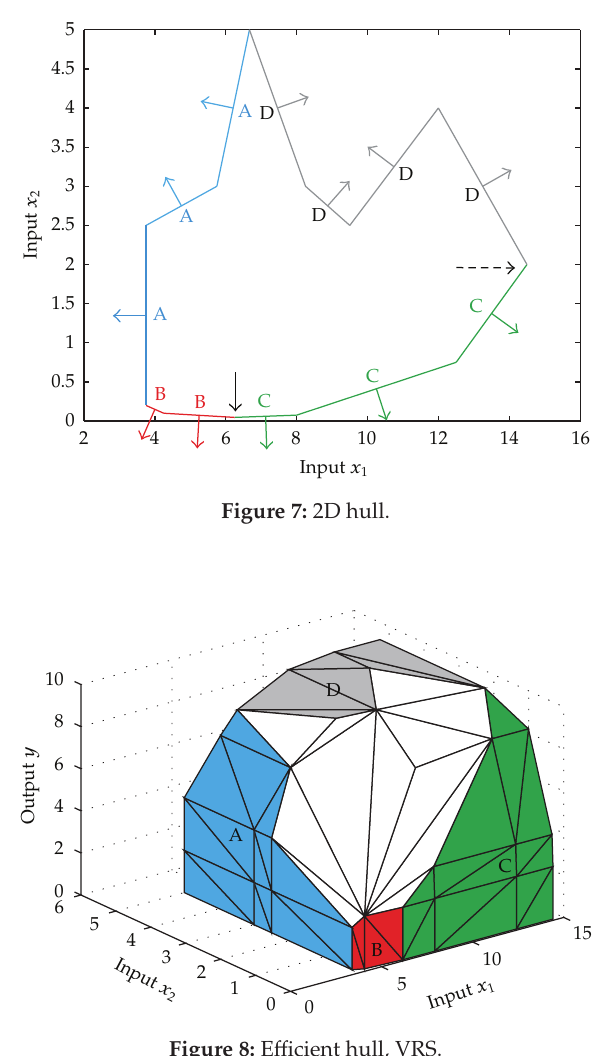
Figure 8: E ffi cient hull,